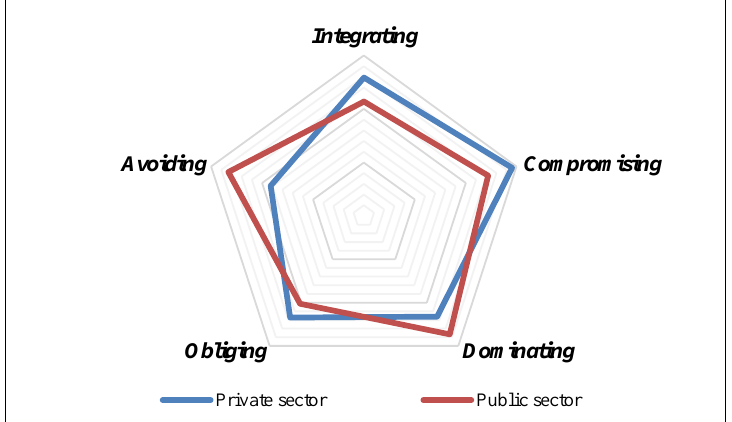
Figure 4. Conflict management styles by sectors